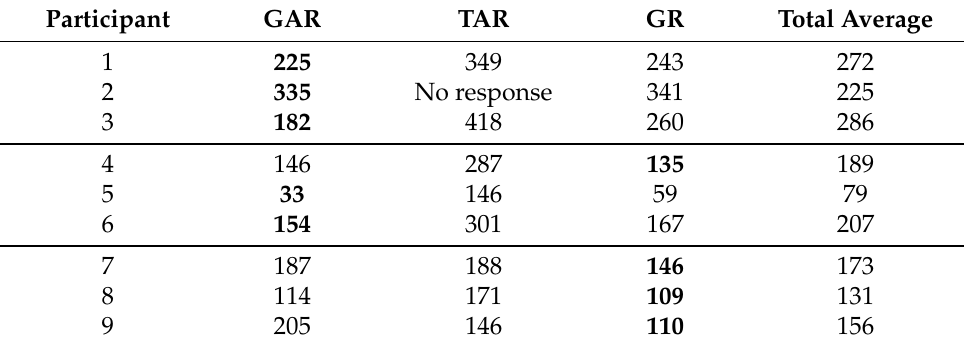
Table 7. Mean response time (in minutes) of each